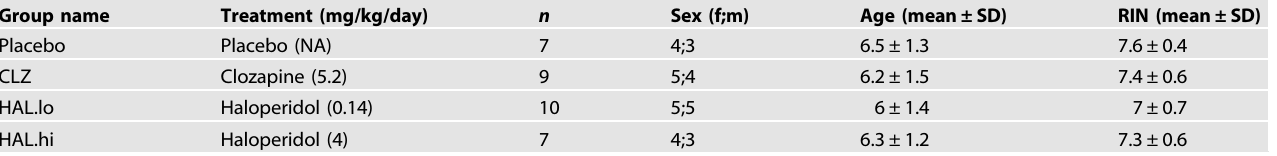
Table 2. Overview of the macaque